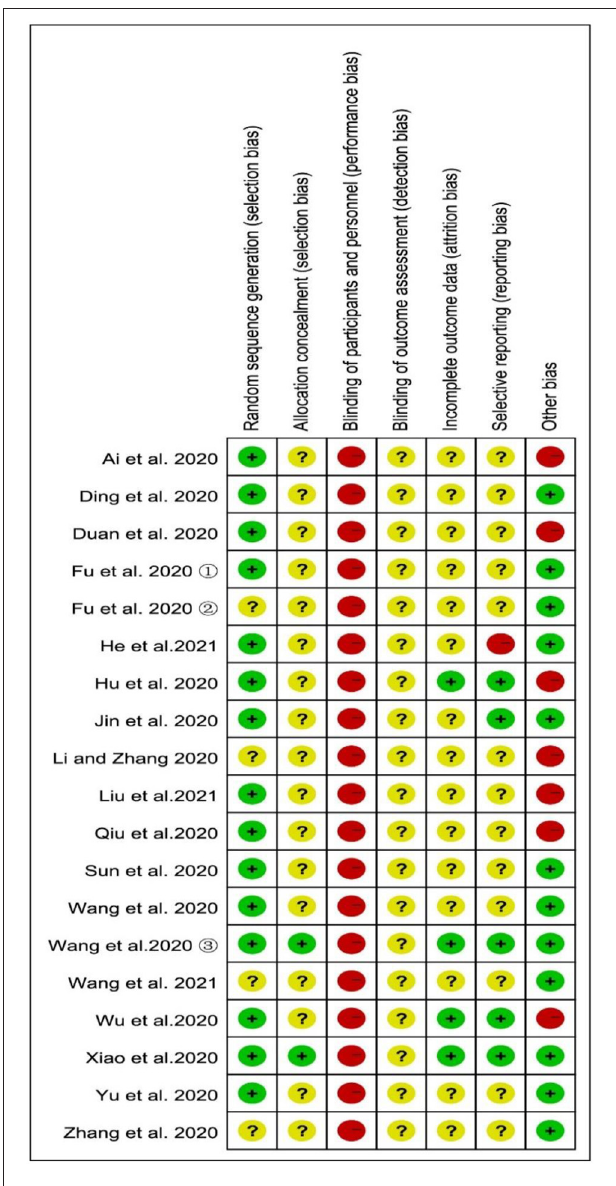
FIGURE 2 | Risk of bias summary.